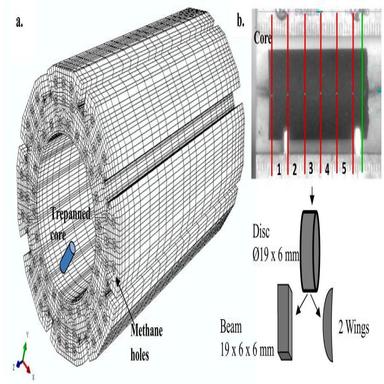
a. Schematic of AGR core brick, b. Photo of trepanned AGR core and schematic of the machining sequence in a typical AGR graphite Post Irradiation Examination Campaign.